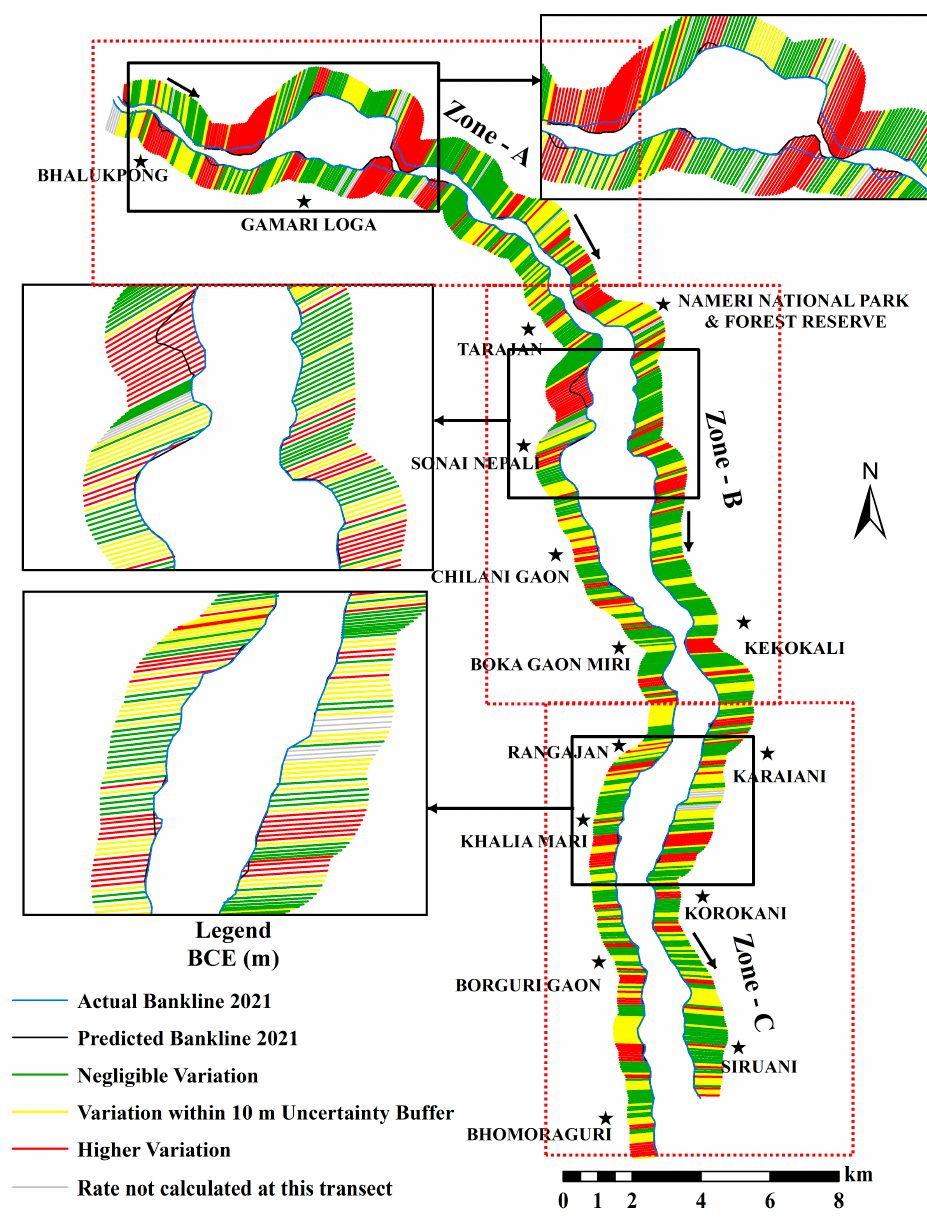
Figure 12. BCE for the forecasting validation.